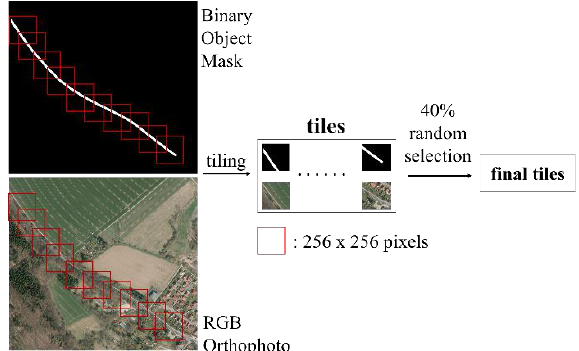
Figure 1: Illustration of the tiling process for a large road object.